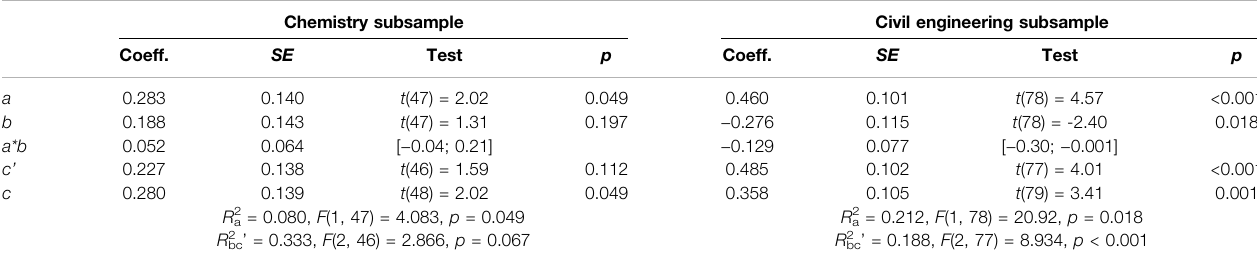
TABLE 5 | Detailed results of the mediation analysis between group awareness (predictor), successful academic help-seeking (mediator) and students ’ satisfaction (criterion). Chemistry subsample